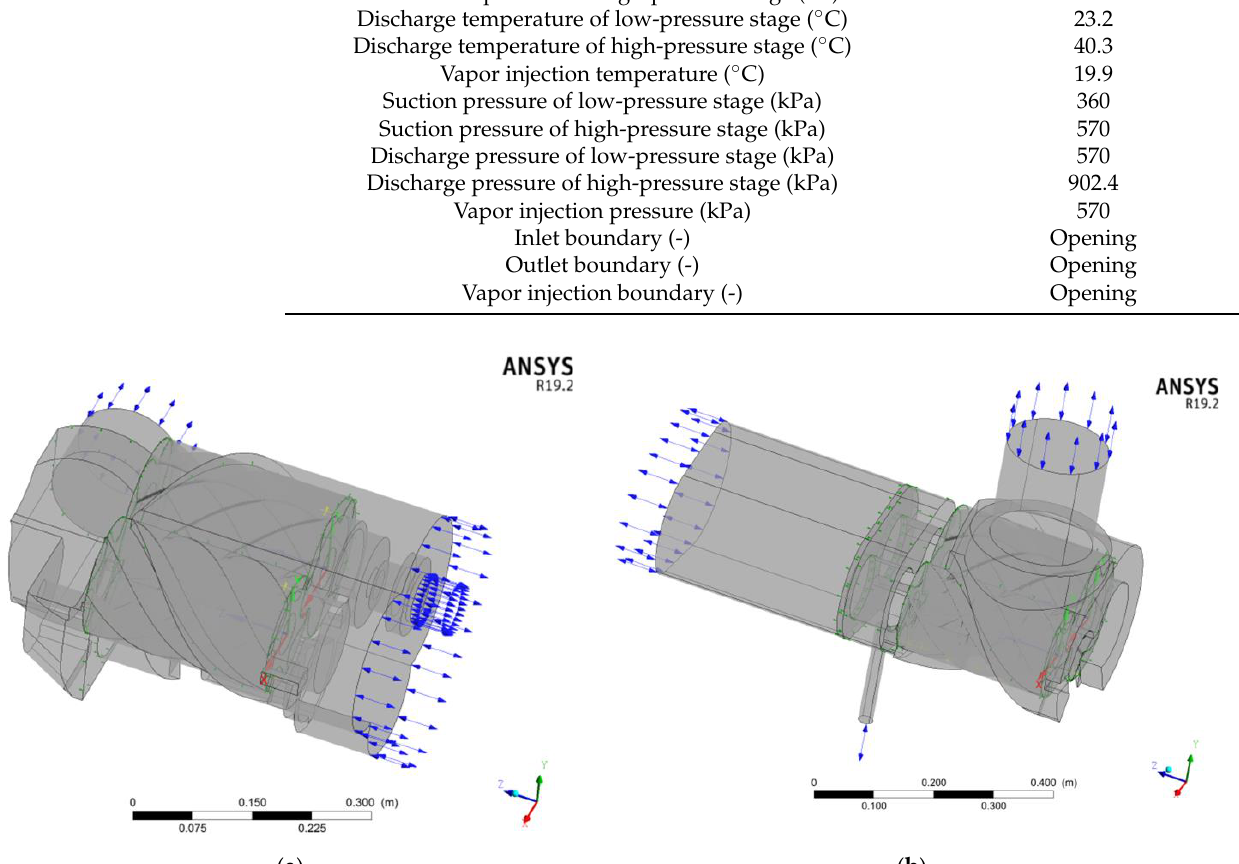
Figure 8. Flow field models: ( a ) flow field model of low-pressure stage; ( b ) flow field model of high-pressure stage.